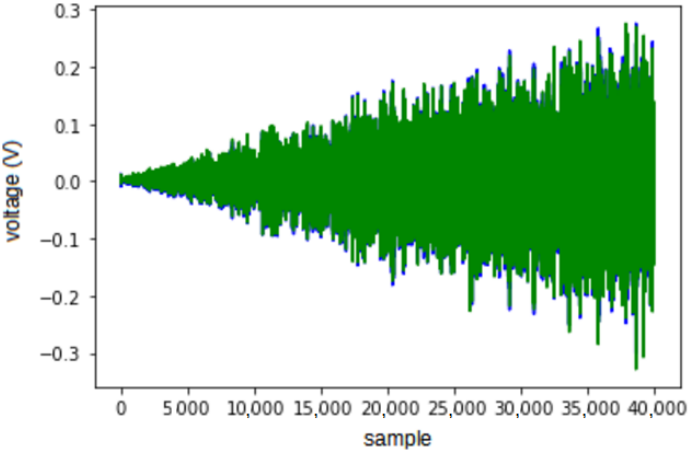
Figure 10. Output from prediction (green) using the best found individual for the Silverbox problem, compared to the empirical data